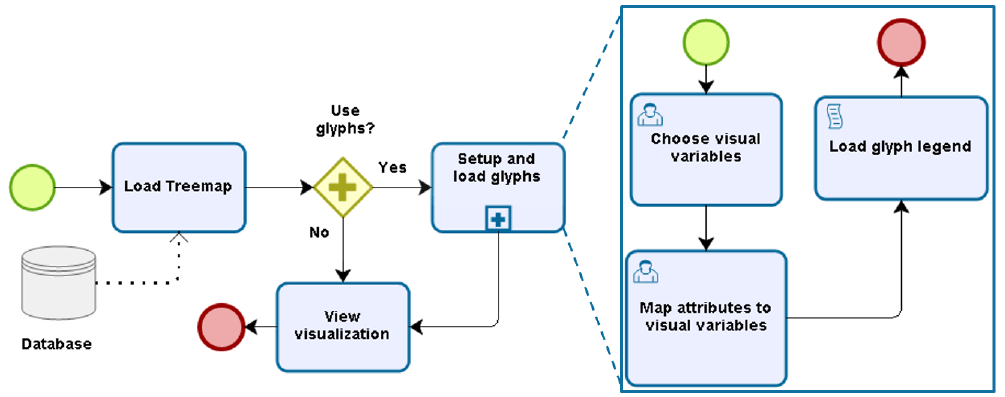
Figure 5. Prototype’s process flow.